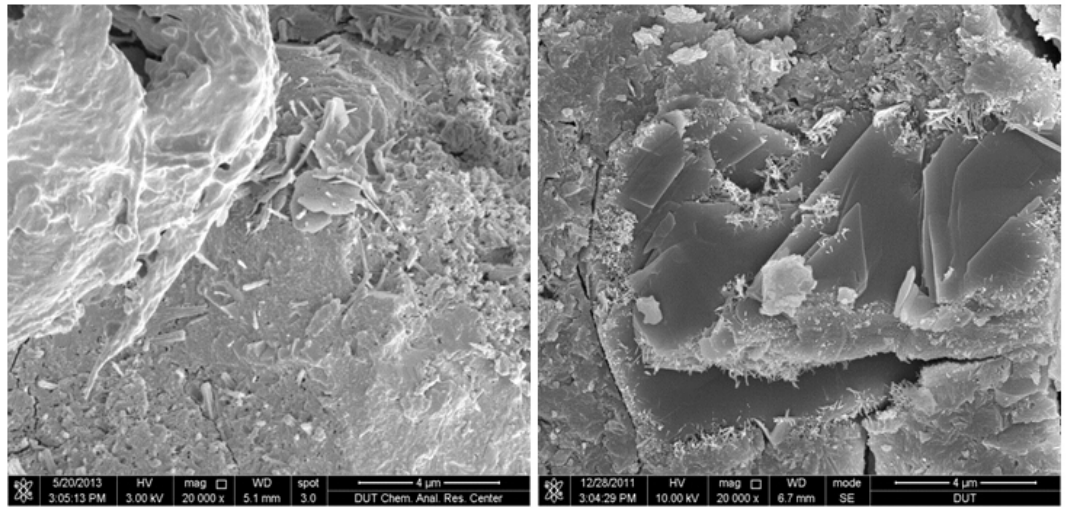
Fig.3. SEM analysis of cement stabilized graded stones